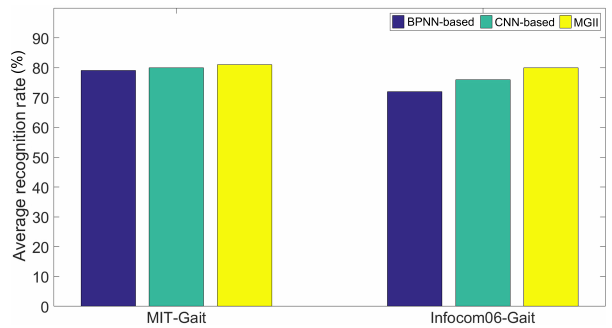
Fig. 7 Recognition rate varies with the number of trainings. Fig. 8 Comparison of average recognition rates.